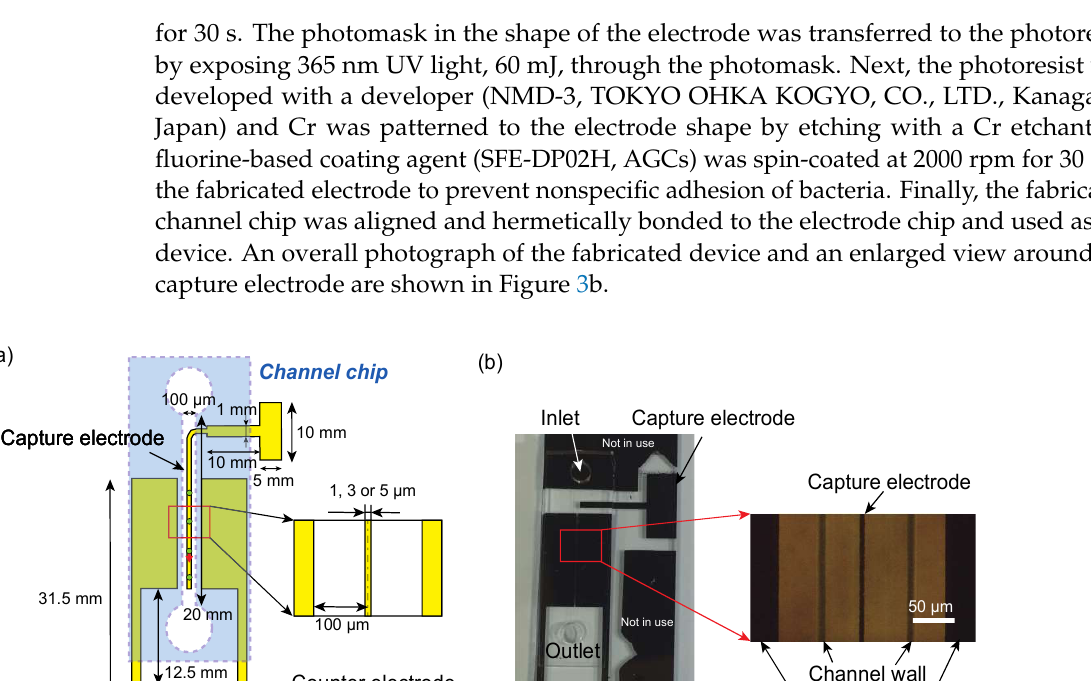
Figure 4. Calculated values of the Clasius-Mossotti equation using the parameters in Table 1: the frequency of 1 MHz was determined as high as possible in the range of positive dielectrophoresis to suppress electrolysis of the electrode from this. Bacteria in the channel are eventually trapped on the electrode because they move to the point of lowest potential. Figure 5b shows the potential energy of the DEP force in the vicinity of the electrode, where the electric field is strongest at the edge of the electrode, as shown in Figure 5c. Therefore, if the capture electrode is wide, bacteria are arranged in